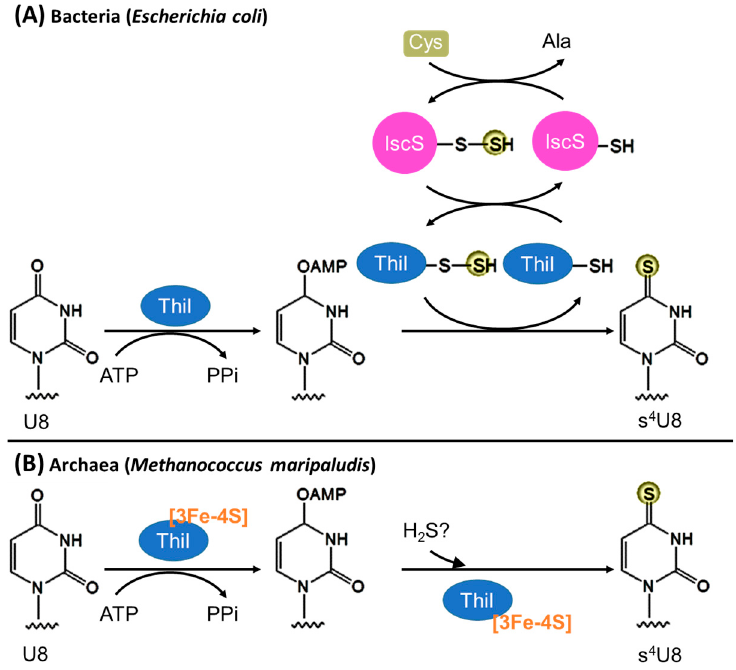
Figure 3. The biosynthetic pathways of tRNA s 4 U8 in Bacteria and Archaea. ( A ) The biosynthetic pathway of s 4 U8 in the bacterium E. coli is Fe–S cluster independent, and the sulfur transfer involves persulfide enzyme adducts; ( B ) The biosynthetic pathway of s 4 U8 in the archaeon M. maripaludis is Fe–S cluster